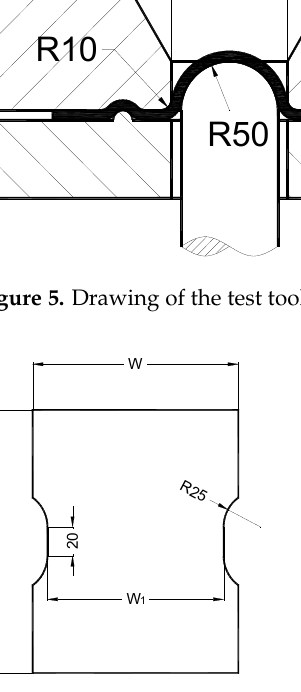
Figure 6. Geometry of test specimen for FLC test in mm.